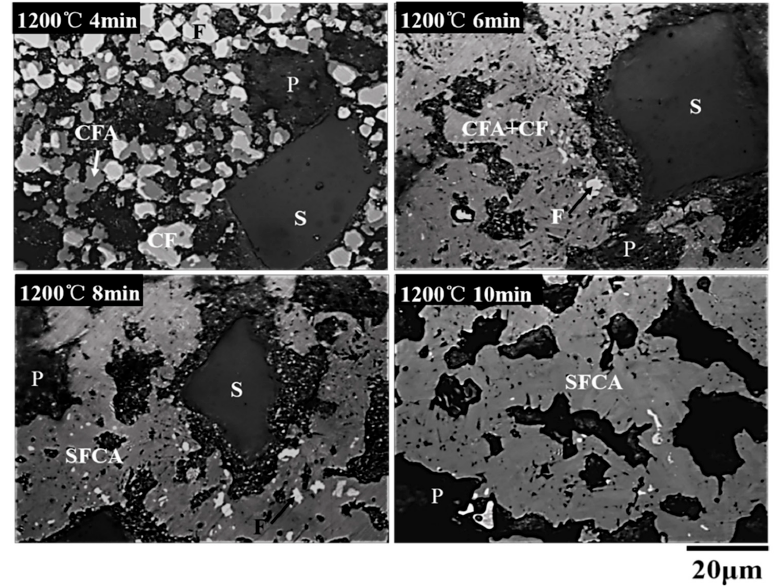
Figure 9. Microscopic photos of the sample C sintered at 1200 ◦ C for different time. F: Fe 2 O 3 , S: SiO 2 , CF: CaFe 2 O 4 , CFA: calcium iron aluminum oxide, SFCA: silico-ferrite of calcium and aluminum, P: